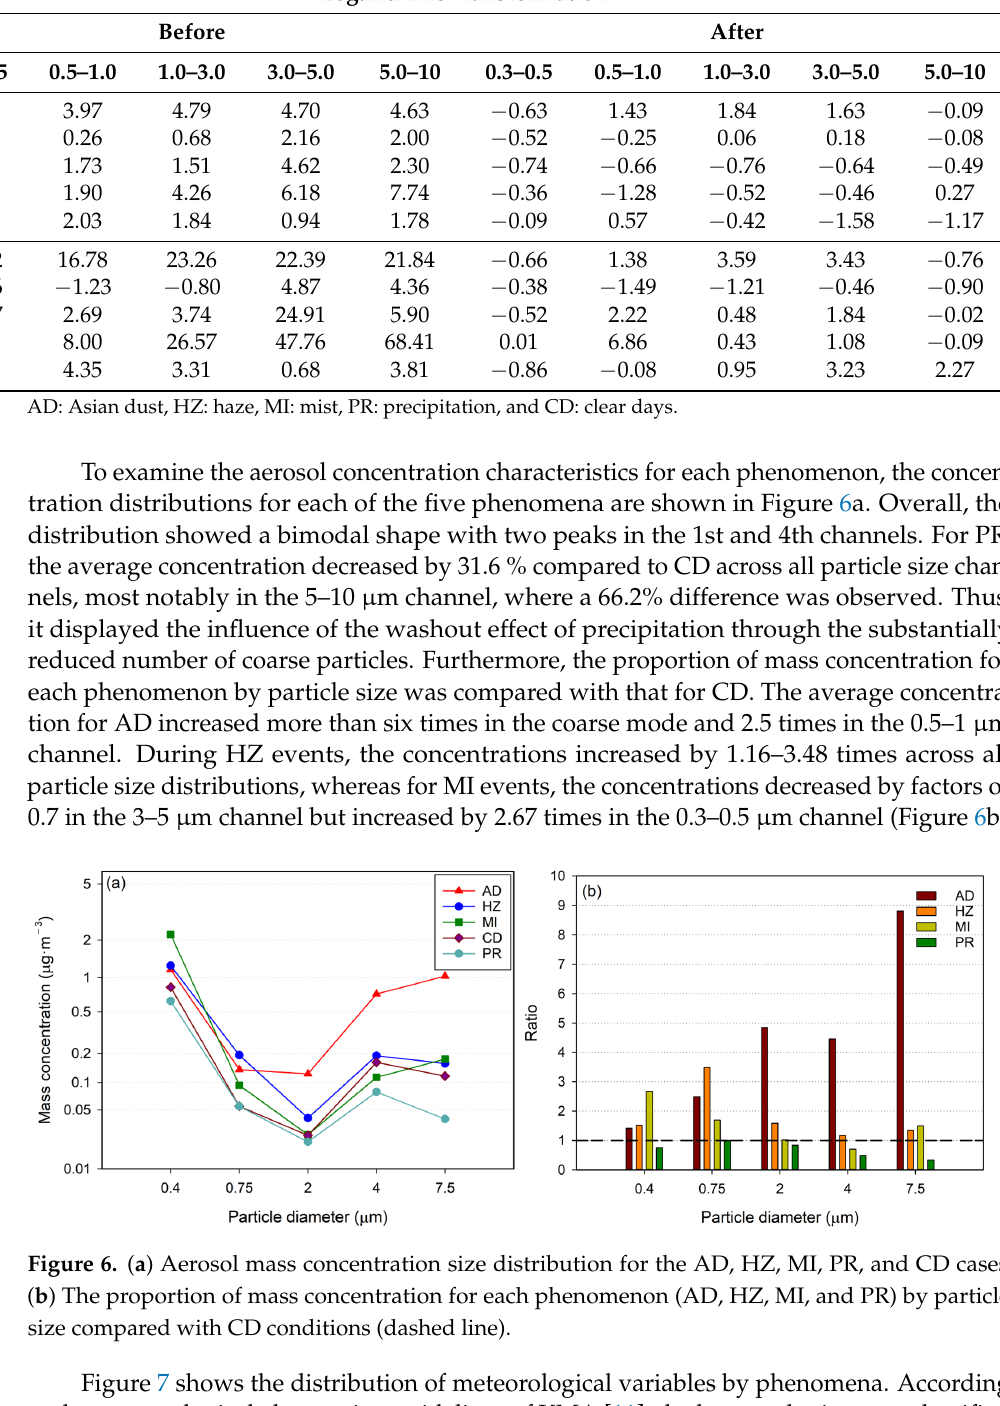
Figure 7. Meteorological factor distributions for each phenomenon: ( a ) temperature and relative humidity, ( b ) pressure and wind speed. AD: Asian dust, HZ: haze, MI: mist, CD: clear days, and PR: precipitation. 3.2. Derivation of Optimal Probability Density Function In general, the particle size distribution of atmospheric aerosols showed a bimodal distribution, with two peaks on either side of the fine and coarse particle areas (~1–2 μ m) due to the influence of various anthropogenic and natural sources [37]. To statistically examine the mass concentration distribution according to measured particle size data, an optimal probability density function with two peaks was calculated using Equation (5). The function was optimized for each of the five weather conditions, and the lognormal distribution constants, M t , D g , and σ values were calculated (summa ‐ rized in Table 4). Figure 8 shows the probability density function of the aerosol mass concen ‐ tration distribution for each phenomenon, indicating their bimodal lognormal distributions.